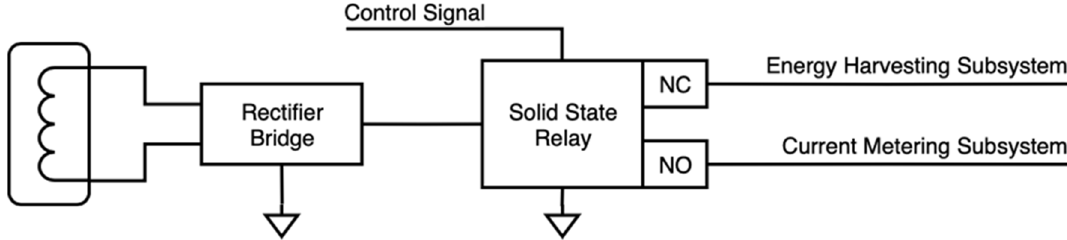
Figure 3. Conceptual schematic of the switching and conditioning circuit, including the harvester, the rectifier, and the solid-state relay.